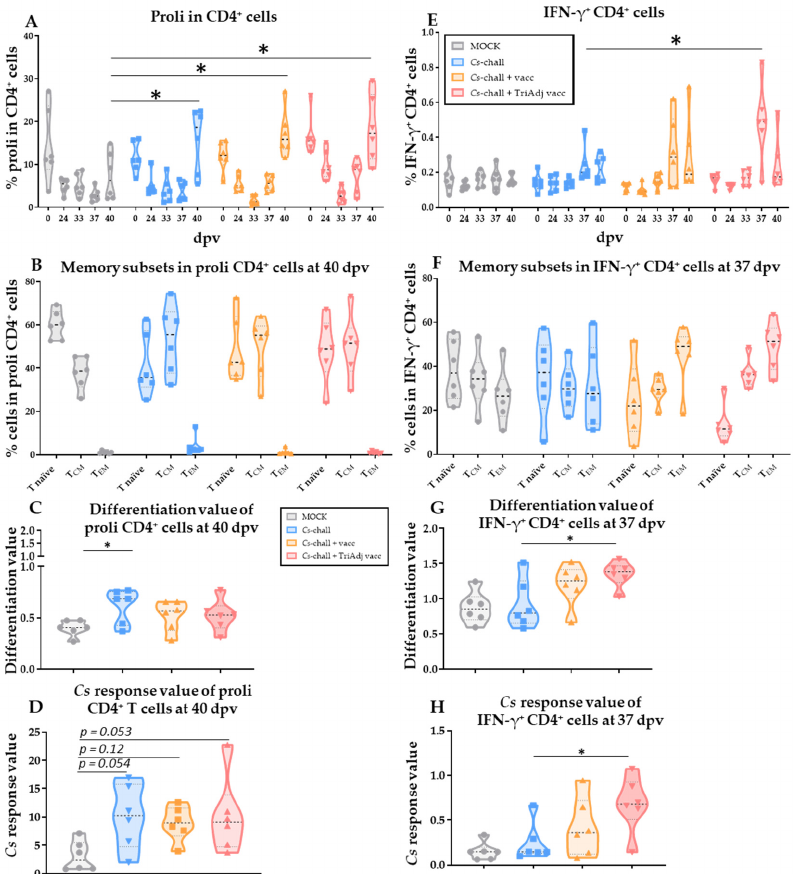
Figure 5. The CD4 T-cell response to C. suis . While C. suis infection induces CD4 T-cell proliferation, intranasal vaccination drives CD4 + T-cell maturation and primes for a stronger IFN- γ response and post-challenge. PBMC from the stated days post first vaccination (dpv) were isolated from MOCK (gray), C. suis challenged ( Cs -chall, blue), C. suis challenged + vaccinated ( Cs -chall + vacc, orange), and C. suis challenged + Tri Adjuvant vaccinated ( Cs -chall + TriAdj vacc, red) pigs. For C. suis -specific proliferative response analysis ( A , D ), PBMC were stained with CellTrace TM Violet and cultured with C. suis lysate for four days. For C. suis -specific IFN- γ production analysis ( E to H ), PBMC were cultured with C. suis lysate for 18 h in the presence of a Golgi inhibitor for the last 4 hours. Cells were then harvested and stained as indicated in Table 1. Proliferating CD4 + (proli CD4 + ) or IFN- γ + CD4 + cells were further di ff erentiated as T naïve , T central memory (T CM ) and T e ff ector memory (T EM ) at specific dpv ( B , F ). Di ff erentiation and response values were calculated for proliferating CD4 + cells ( C , D , respectively) and for IFN- γ + CD4 + cells ( G , H , respectively). Values for individual pigs, medians, and 25 / 75 percentiles are shown. Data were analyzed using repeated measures two-way ANOVA in comparison to MOCK ( A , B ) and Cs -inf animals ( E , F ) with Dunnett’s multiple comparisons test, and with one-way ANOVA in comparison to MOCK ( C , D ) and Cs -chall animals ( G , H ). * p <